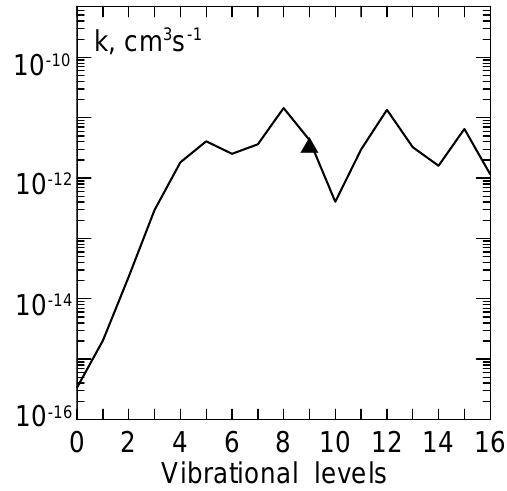
Fig. 5. The calculated quenching rate coefficients of O 2 ( c 1 6 − u , v =0–16)+N 2 (solid line) are compared with experimental data by Fig.5. Copeland et al. (1996) (triangle).